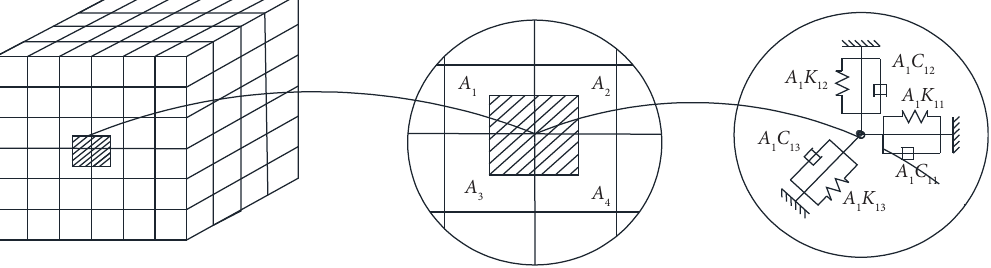
Figure 1: 3D viscoelastic